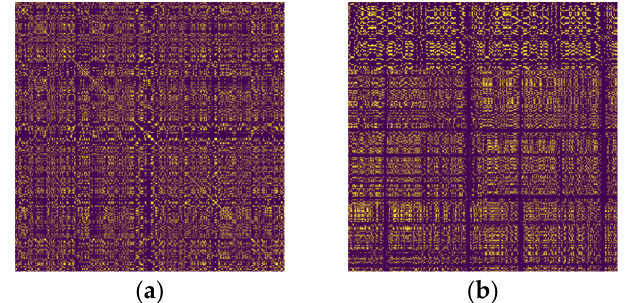
Figure 1. RP conversion image. ( a ) RP conversion image; ( b ) VMD–RP conversion image.